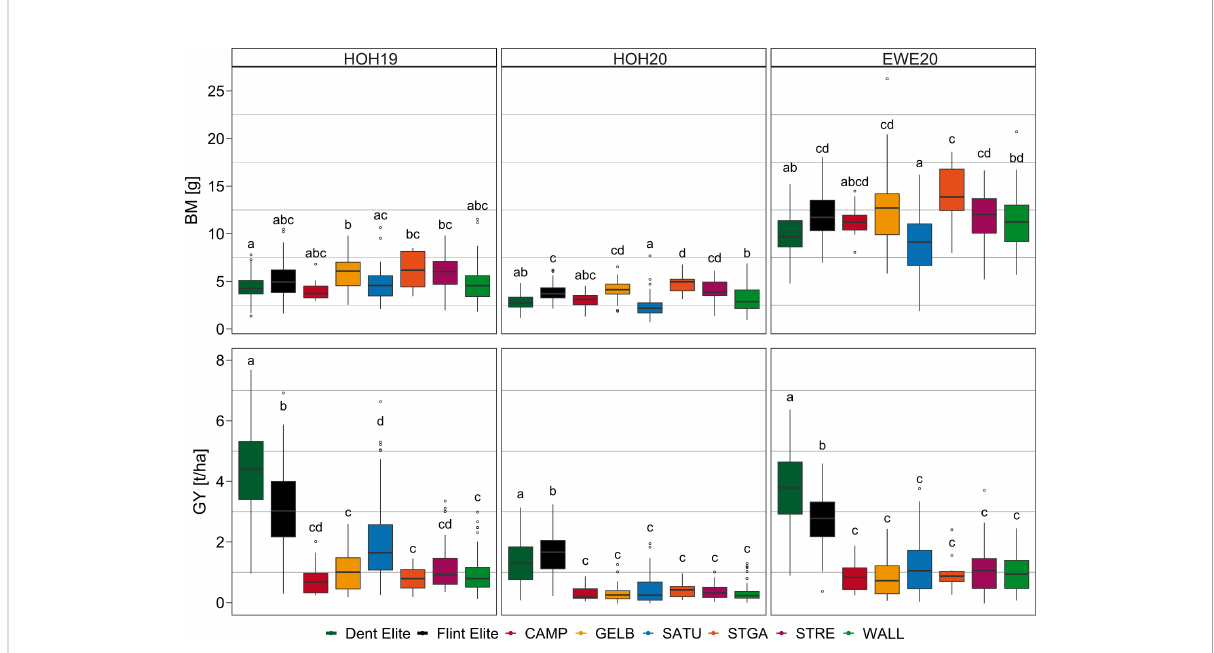
FIGURE 5 Biomass (BM) and grain yield (GY) values for single population groups by environment (HOH19, HOH20, EWE20) in -P. Population groups are divided into Dent and Flint elite lines and landrace doubled haploid lines. Note that landrace doubled haploid lines are further split up in their original six European Flint landraces. CAMP = Campan Galade, GELB = Gelber Badischer Landmais, SATU = Satu Mare, STGA = St Galler Rheintaler, STRE = Strenzfelder, WALL = Walliser. Means with shared letters were not signi fi cantly different using least signi fi cant